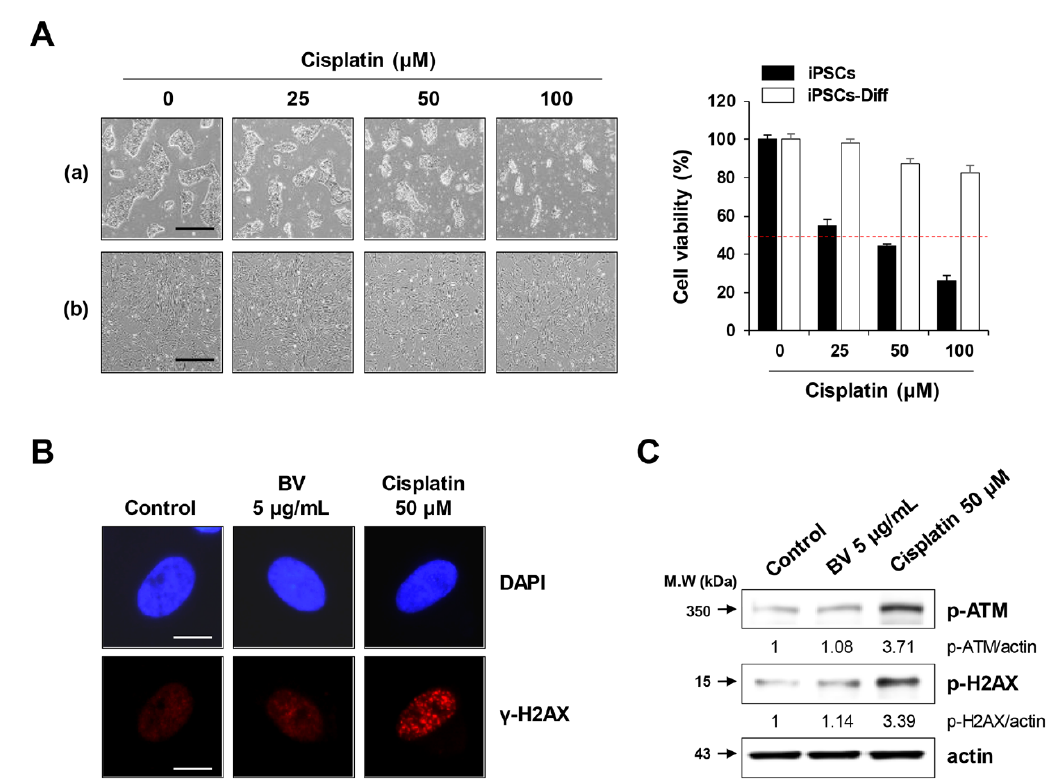
Figure 6. E ff ects of BV on the DNA damage in iPSCs-Di ff . ( A ) iPSCs and iPSCs-Di ff were seeded in 12-well culture plates and incubated in the presence of cisplatin at 25, 50, and 100 µ M for 24 h. Cells were photographed under an inverted microscope and relative cell viability compared with cisplatin-untreated control cells was determined. Data are expressed as means ± SD from triplicate samples. Scale bar = 100 µ m. ( B ) iPSCs-Di ff grown on confocal dishes were treated with 5 µ g / mL BV or 50 µ M cisplatin for 24 h. Cells were stained with anti-p-H2AX antibody followed by Alexa 594-conjugated anti-rabbit antibody. After counterstaining nuclei with DAPI, γ -H2AX foci were observed under a fluorescence microscope. Scale bar = 20 µ m. ( C ) BV- or cisplatin-treated iPSCs-Di ff were analyzed for the protein levels of p-ATM and p-H2AX by Western blotting. Data are representative of two independent